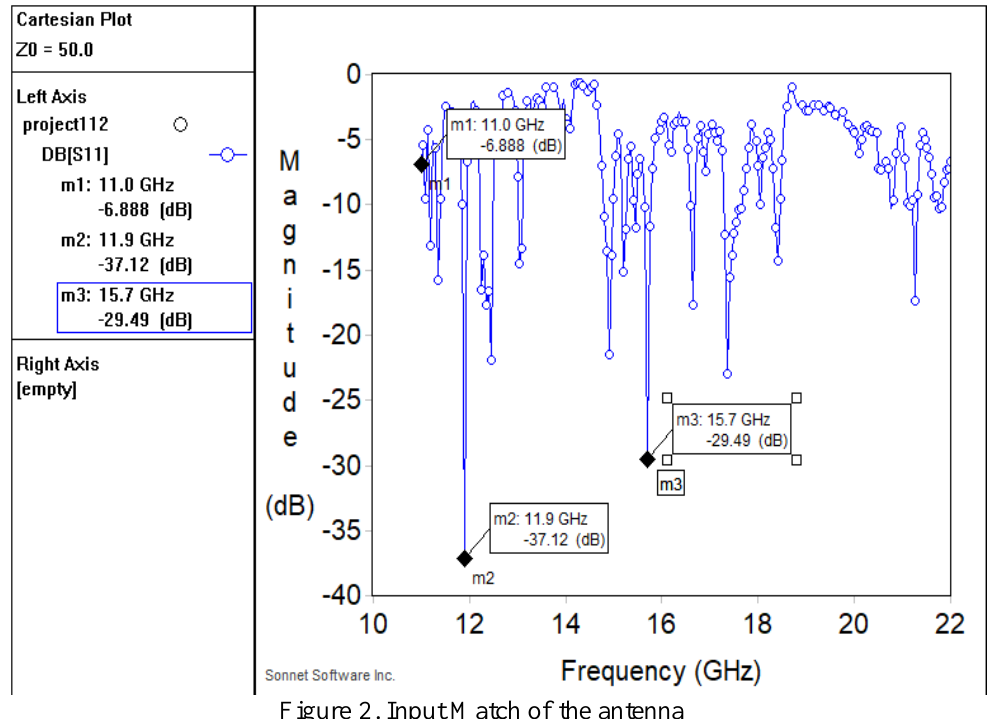
Figure 2. Input Match of the antenna